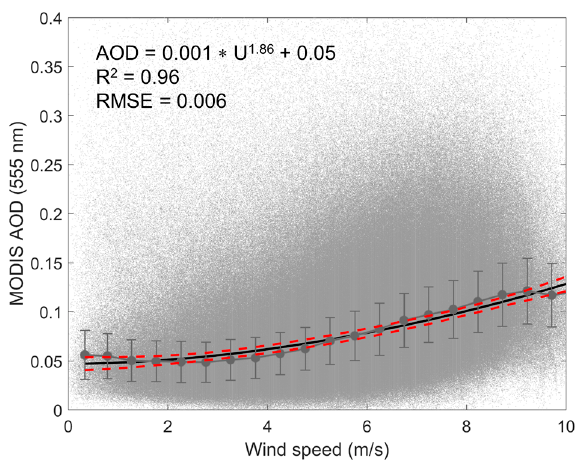
Figure 3. MODIS-adjusted AOD (grey dots) on pixel basis versus surface wind speed for summer 2007. The grey solid circles denote the median AOD and corresponding median absolute deviation for the binned data. The black solid and red dashed lines denote a power fit and corresponding 95% confidence interval, respectively. The R 2 and RMSE values were calculated based on the power fit of the median values. Atmosphere 2018 , 9 , x FOR PEER REVIEW